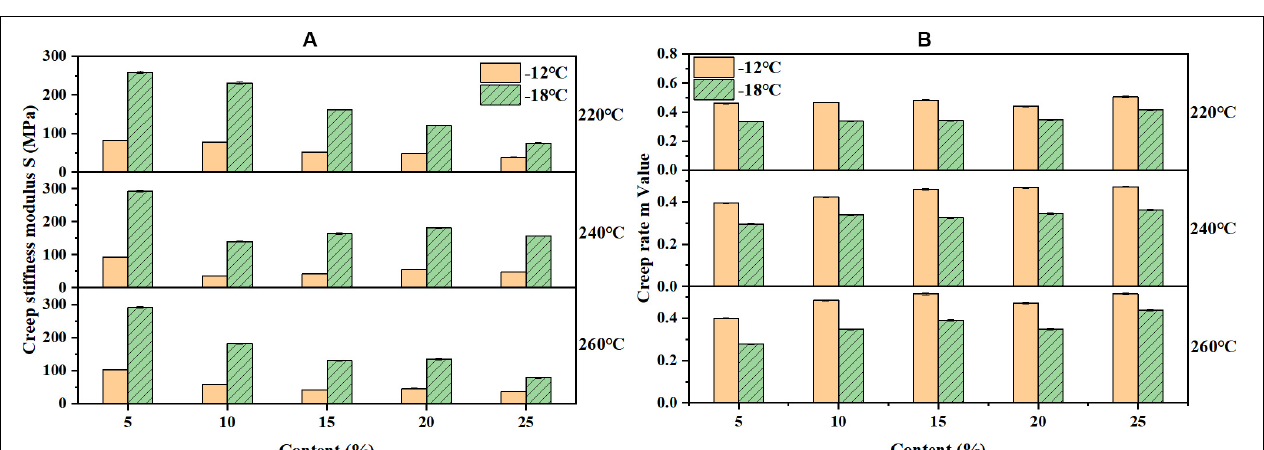
FIGURE 6 | Creep stiffness and m -value of TB-A. (A) Creep stiffness of TB-A. (B) m -value of TB-A.